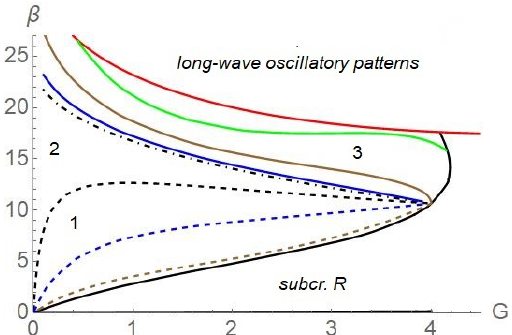
Figure 8. Stability map of the stationary rolls in the case without surfactant. The solid black line is the boundary line between supercritical and subcritical rolls (“subcr. R”). Region “1” (below the dashed line) is the region of unstable rolls; in region “2”, rolls are stable within q 2 < q 2 m and monotonically unstable for q 2 m < q 2 < q 2 ; region “3” (above dot-dashed line) is the region of stable 0 rolls for q 2 < q 2 osc , oscillatory unstable for q 2 slightly above q 2 osc , and oscillatory or monotonically unstable for any q 2 osc < q 2 < q 2 . Dashed and solid lines: blue color for χ 2 = 2, brown color for χ 2 = 5, 0 green color for χ 2 =